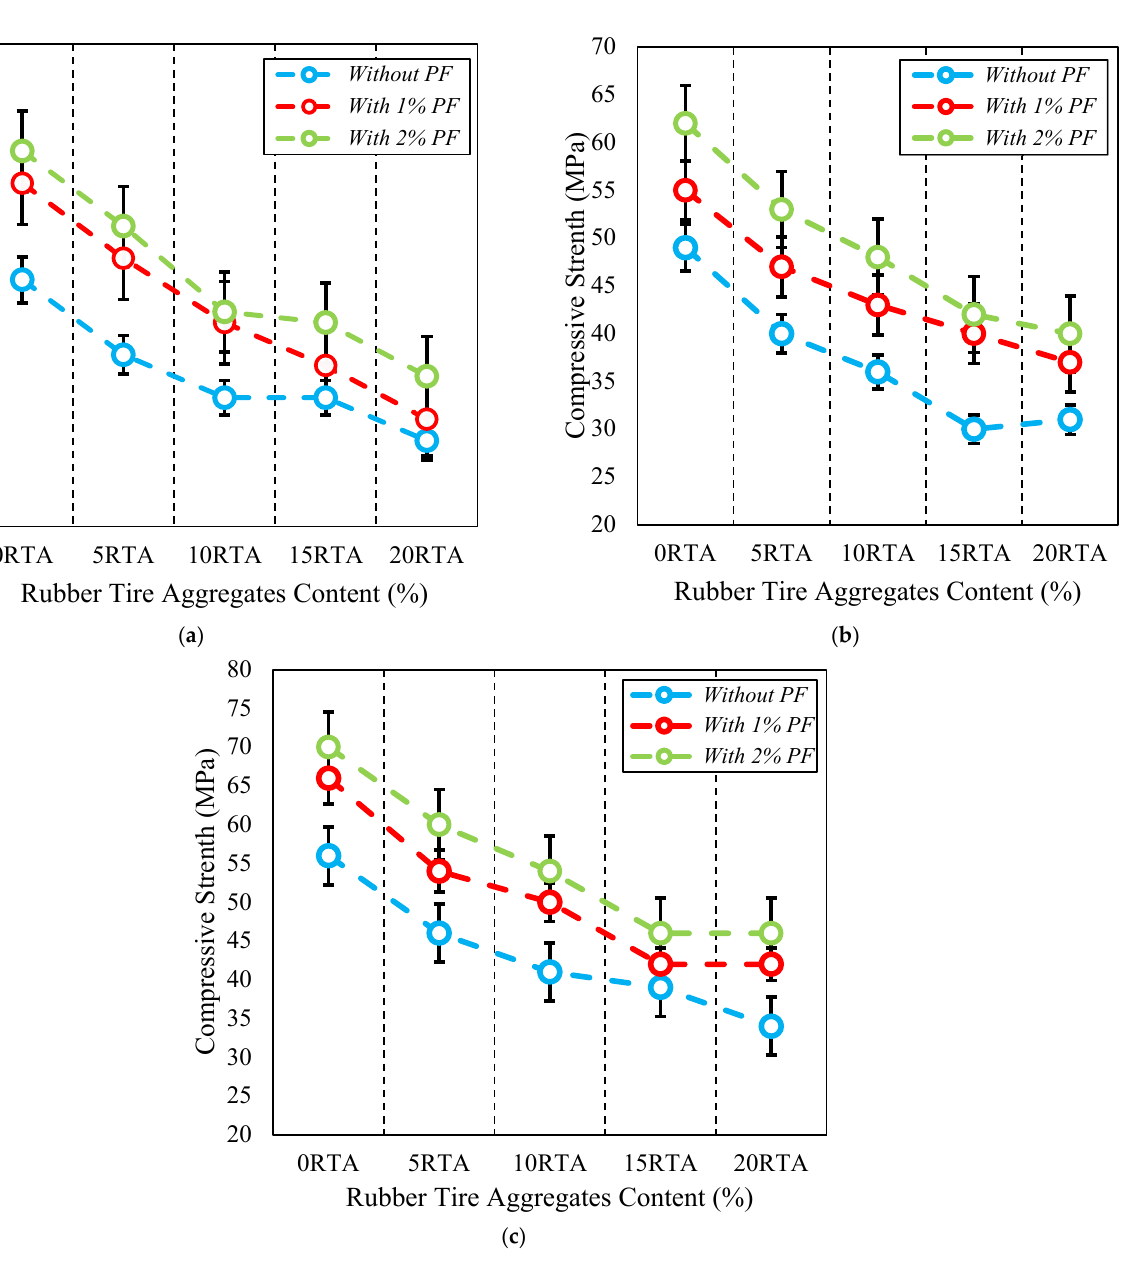
Figure 8. Compressive resistance of concrete having various PF and RTA fractions at: ( a ) 7 days; ( b ) 28 days and; ( c ) 56 days of